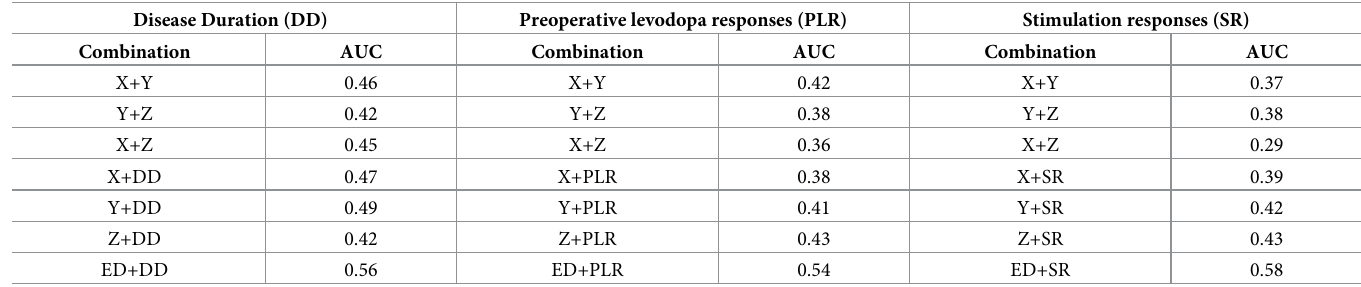
Table 4. The area under the curve (AUC) from the first step for each combination are listed separately for each independent variable namely disease duration (DD), preoperative levodopa responses (PLR) and stimulation response (SR). Disease Duration